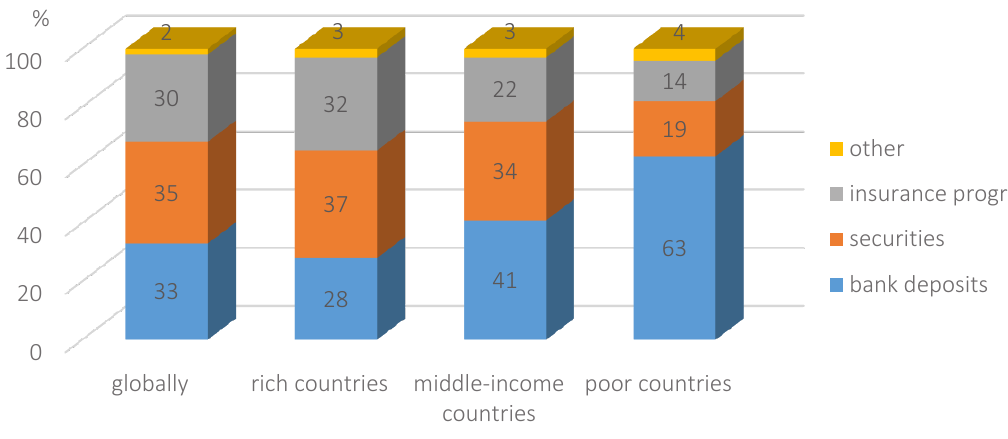
Figure 3. The share of different types of assets in the general structure of world savings in 2019,